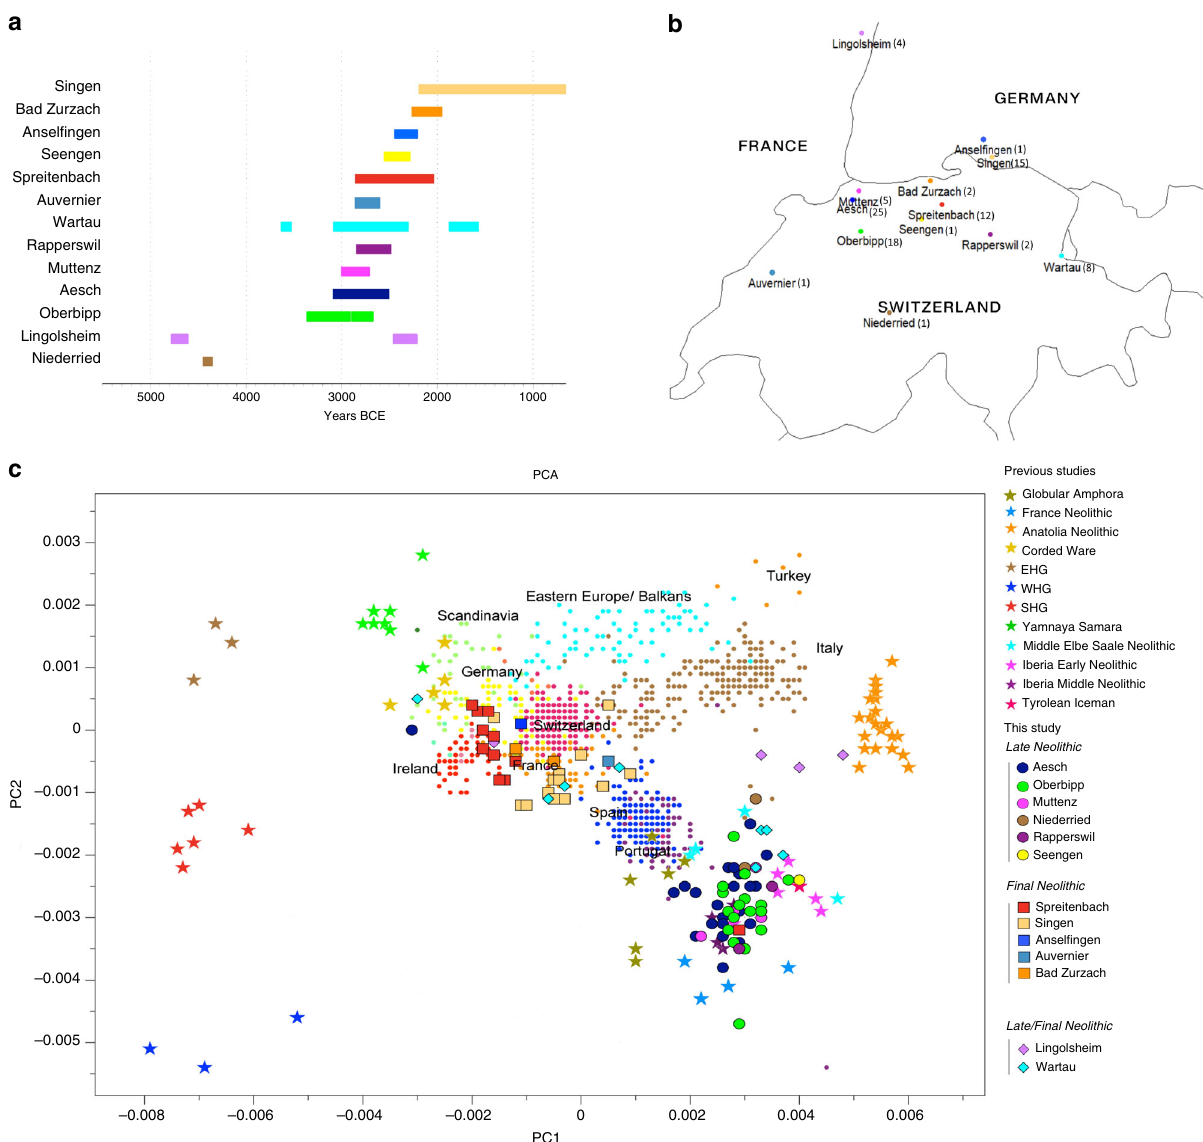
Fig. 1 Genetic, temporal, and spatial structure of individuals in this study. a Time ranges of calibrated radiocarbon dates of the archaeological sites. b Geographical distribution of the sites and samples sizes per sites in brackets. Map generated with R version 3.4.3 (R Core Team 2017) using the CIA World Data Bank II currently (mid 2003) available from http://www.evl.uic.edu/pape/data/WDB/. c PCA was reconstructed on 1960 modern European individuals of the POPRES dataset and ancient genomes were projected onto